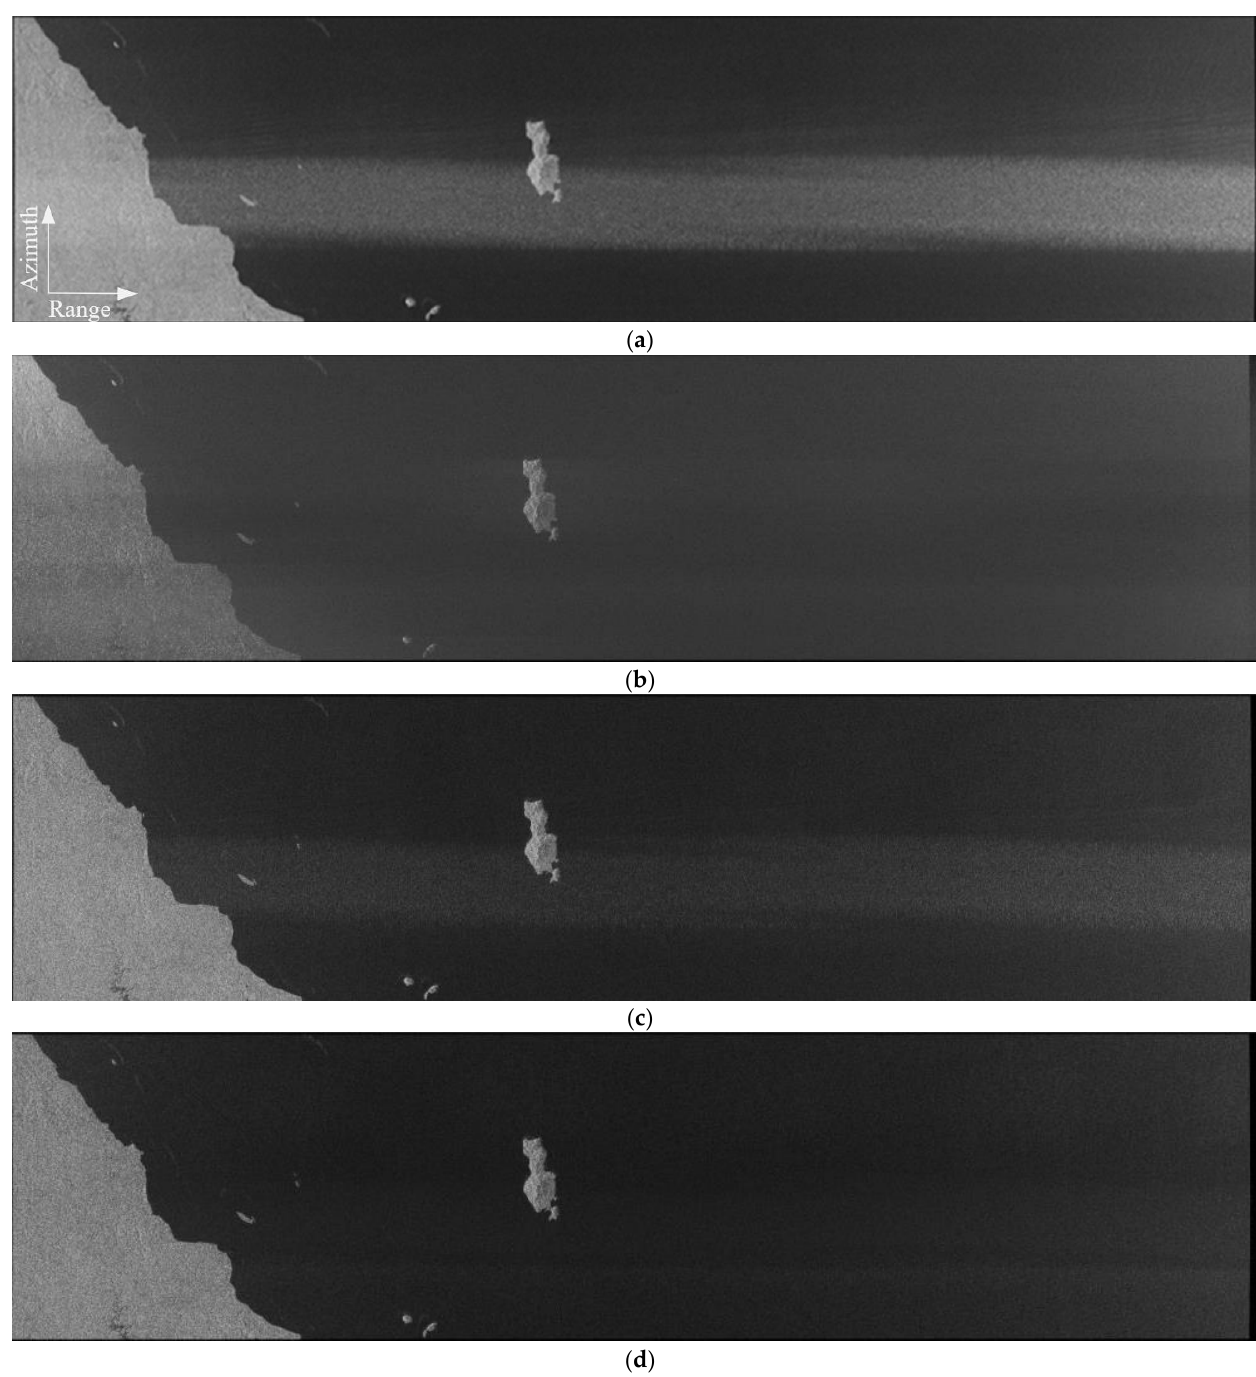
Figure 13. Experimental results for scene 1. ( a ) SAR SLC image without mitigation process. ( b ) Mit- igation result by FNF method. ( c ) Mitigation result by ESP method. ( d ) Mitigation result by pro- posed method.